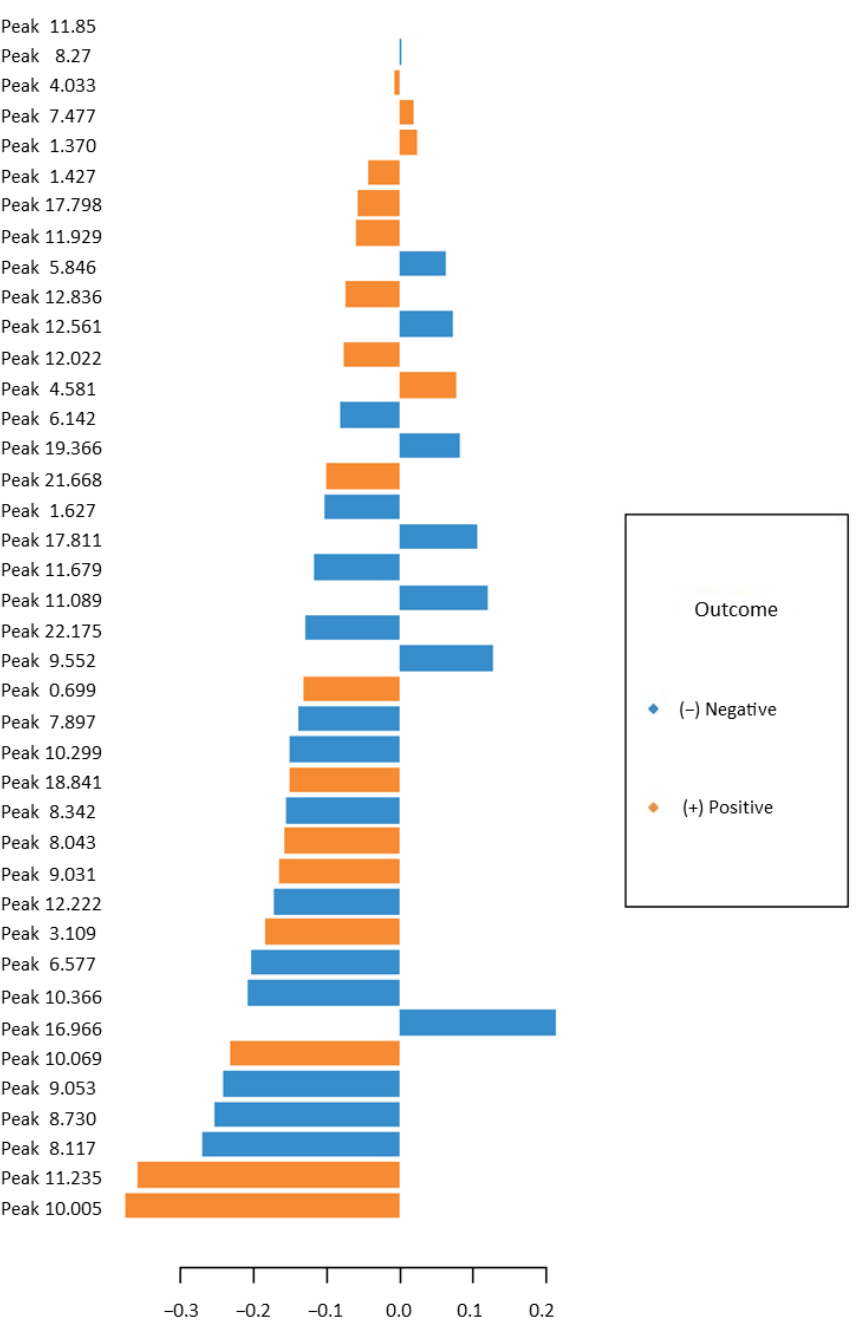
Figure A2. Importance and Feature Contribution of 40 Features of Interest, corresponding to compo- nent 2 in Figure 1.